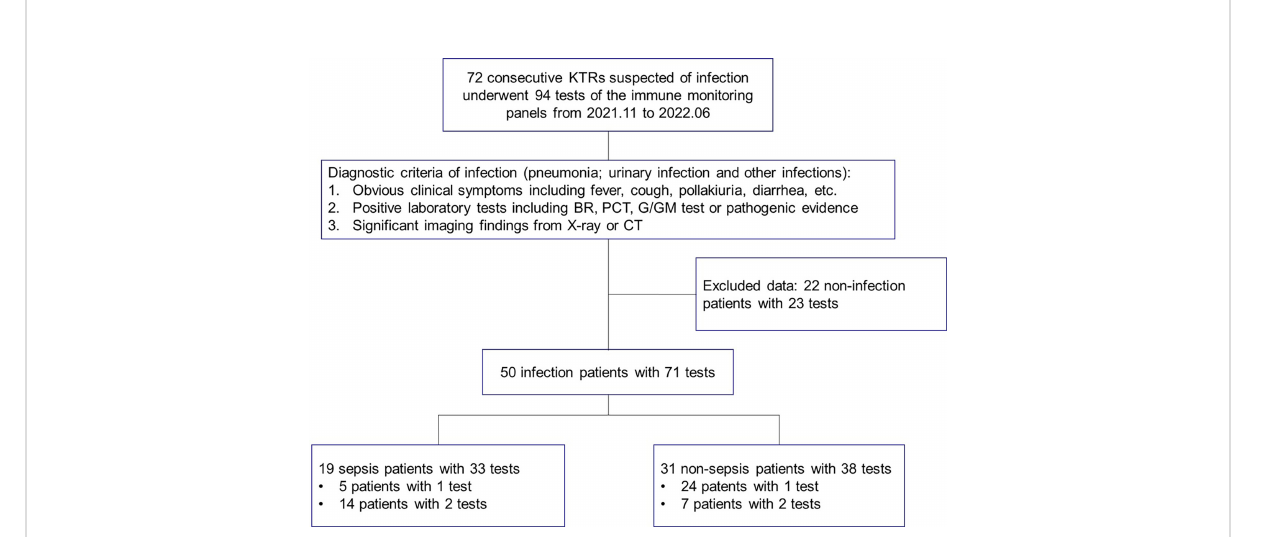
FIGURE 1 The study fl ow and diagnostic criteria of infection. 72 KTRs with 94 tests of immune function panels were fi rst enrolled. 50 KTRs conformed of infection were further classi fi ed into the sepsis group and non-sepsis group according to the de fi nition for sepsis. KTRs, kidney transplant recipients; BR, blood routine examination; PCT, serum procalcitonin; G/GM test, (1-3)-beta-D-glucan or galactomannan test; CT, computed